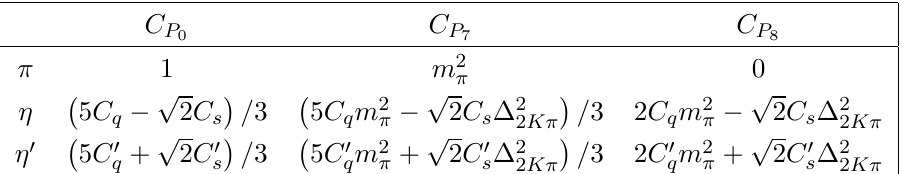
for the local interaction. i